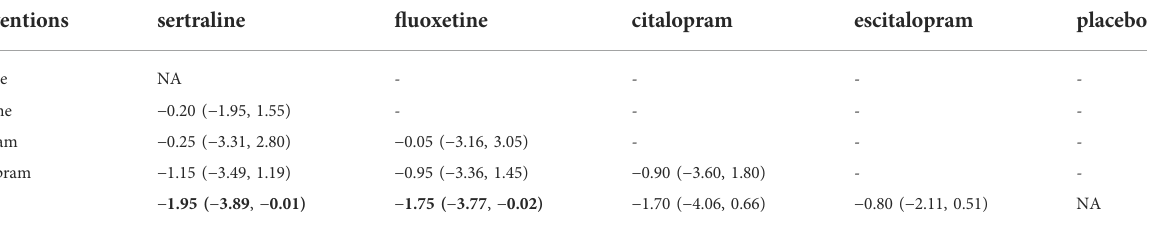
TABLE 2 Network Meta-analysis of binge frequency.